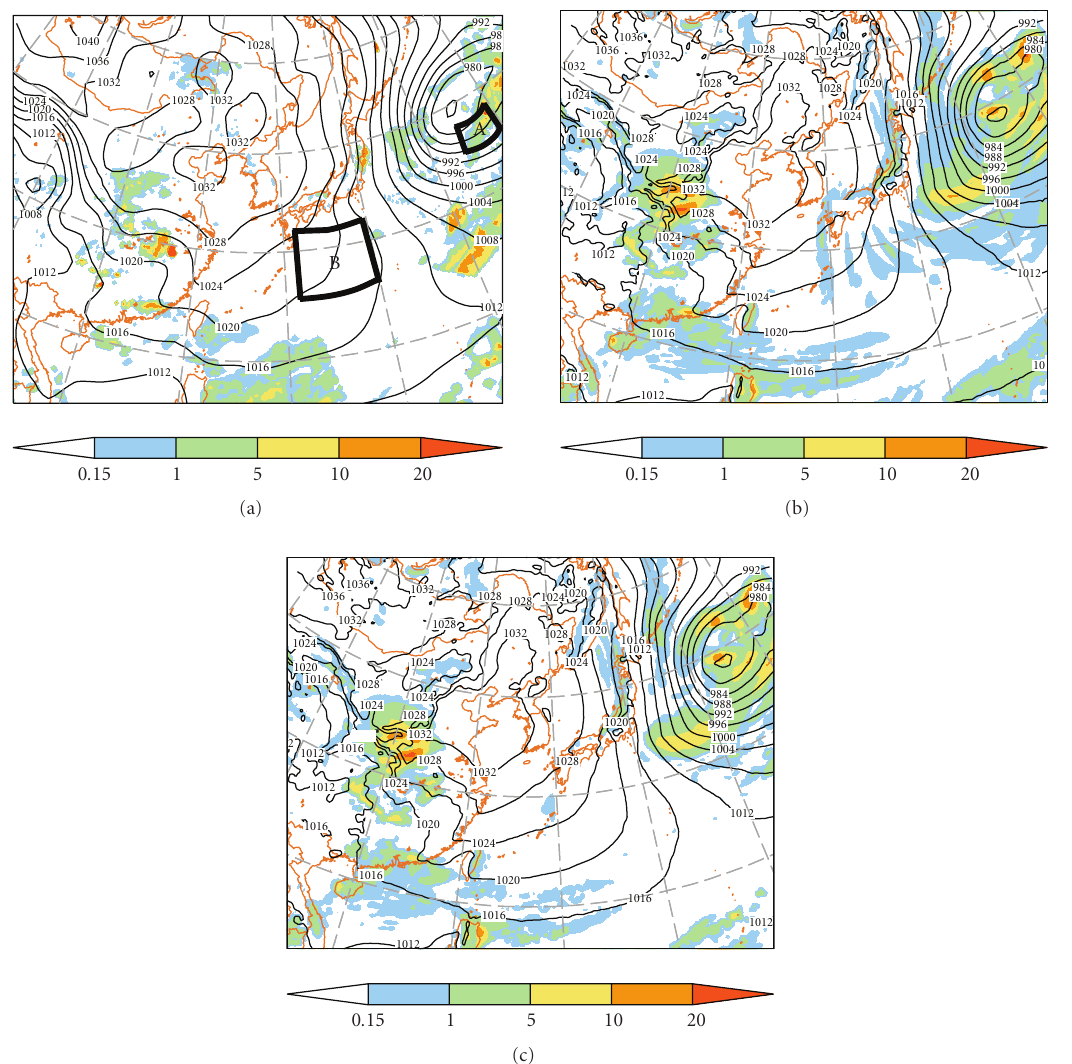
Figure 2: The 6 hours accumulated rainfall amount (mm) and averaged sea level pressure (SLP) from 0600 UTC to 1200 UTC 24 February 2008, obtained from the (a) TMPA observation for the rainfall and FNL data for the SLP, (b) WSM6, and (c) WDM6 experiments. Model integrations were conducted during the 36-h from 0000 UTC 23 February 2008. The marks “A” and “B” in Figure 2(a) designate the precipitating and nonprecipitating